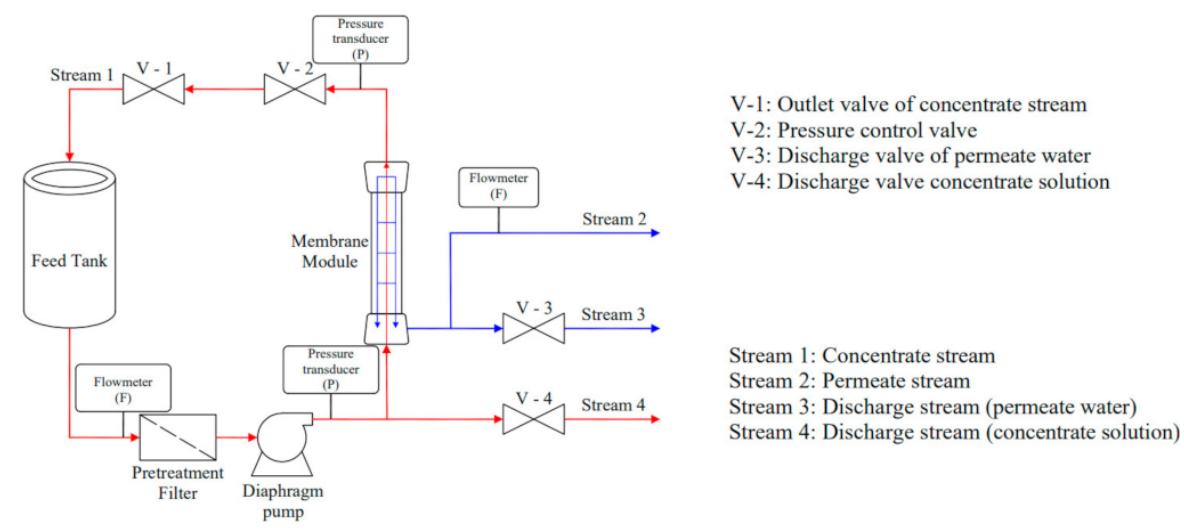
Figure 1. Schematic diagram of RO membrane separator configuration. The pressure transducers measured the hydraulic pressures of the feed side at the entrance and exit of the membrane module as gauge pressure. The operating feed pressure was obtained from the average of both the inlet and outlet readings. The measurements of permeate flowrate were taken every 10 min, and the concentration of YPFS solution was evaluated via ◦ Brix analysis using a digital refractometer (LC-DRT-948, Shanghai Lichen Bangxi Instrument Technology Co., Ltd. in Shanghai, China) by sampling the YPFS solution during the experiment. The termination of the experiment was set at the point when the permeate flux was lower than 0.5